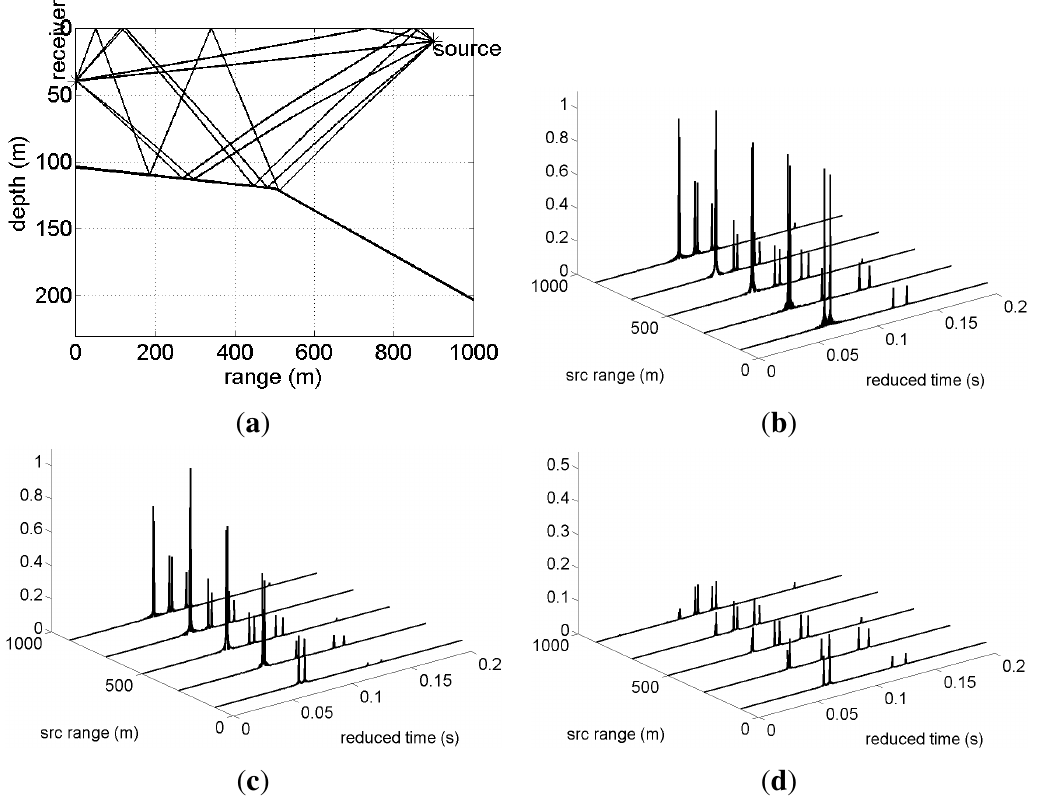
Figure 3. Makai’05 simulation scenario of Figure 2: eigenrays for a source at 900 m ( a ); and arrival patterns for various source ranges—pressure ( b ); horizontal particle velocity ( c ); and vertical particle velocity ( d